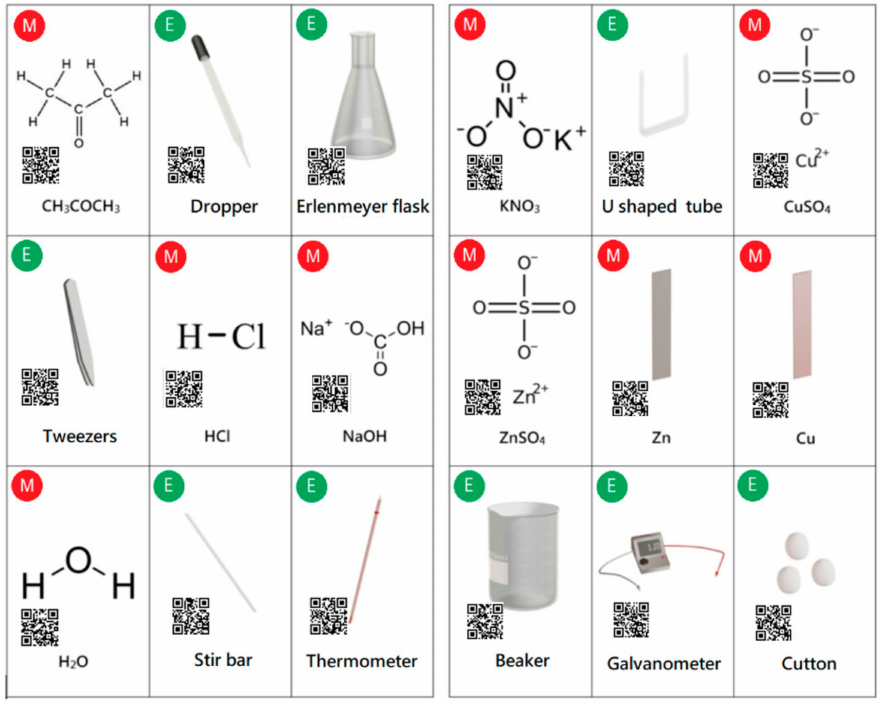
Figure 8. The pictures, names and quick response (QR) codes of all equipment and